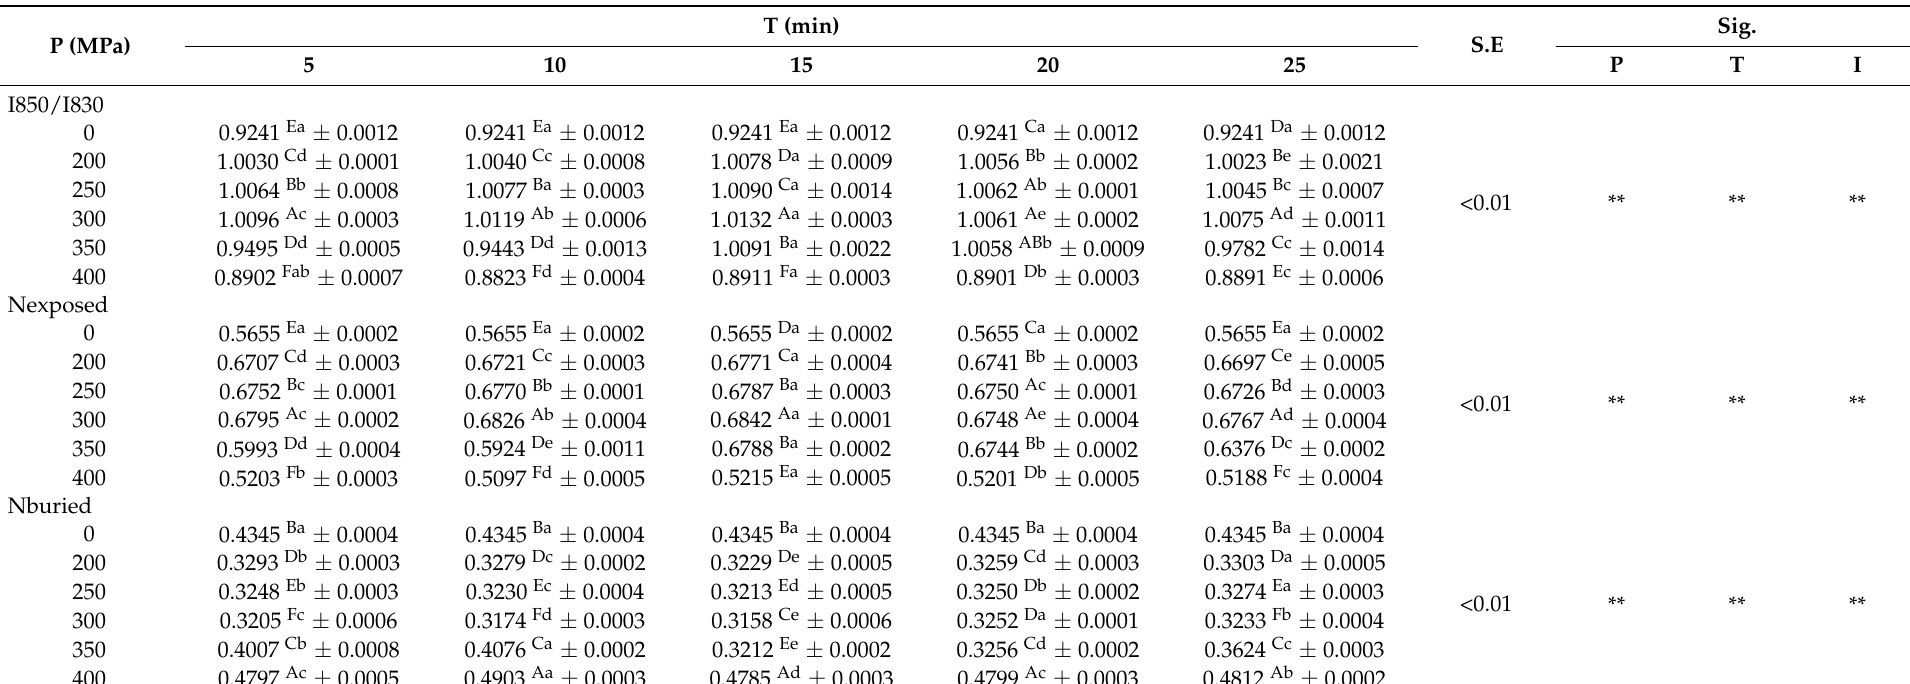
Table 2. The conjugate bimodal ratio of different high hydrostatic pressure treatments to cowhide collagen I850/I830 double band and the mole fraction of exposed (hidden) tyrosine